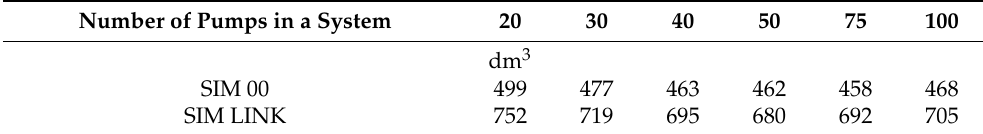
Table 2. The values of average wastewater inflows to a single pumping station depending on the type of study and the number of pumps in the